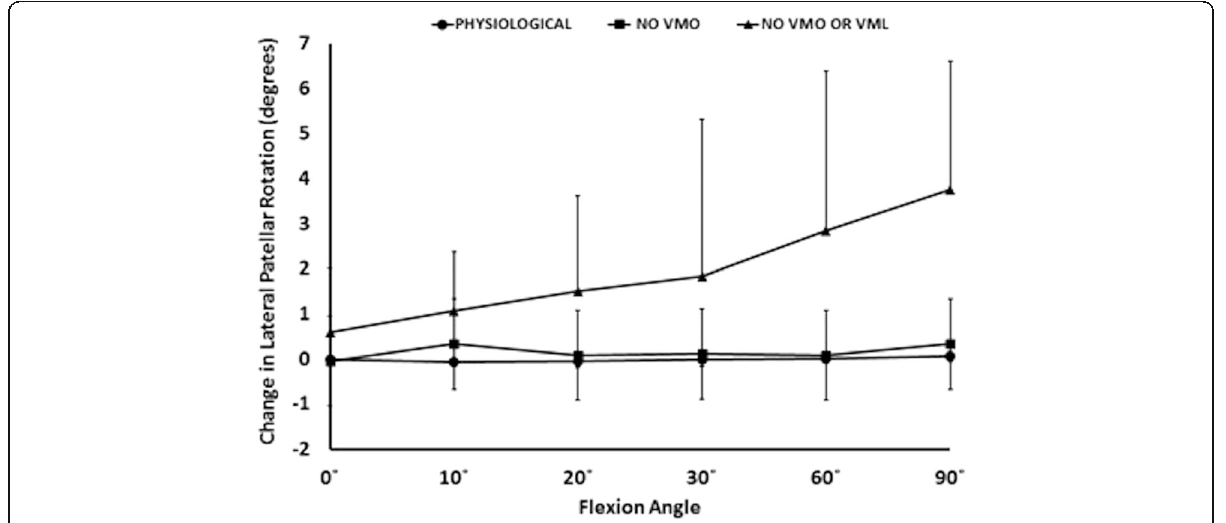
Fig. 10 Relaxation of the VMM led to increased patellar lateral rotation; that is: the distal pole moved relatively